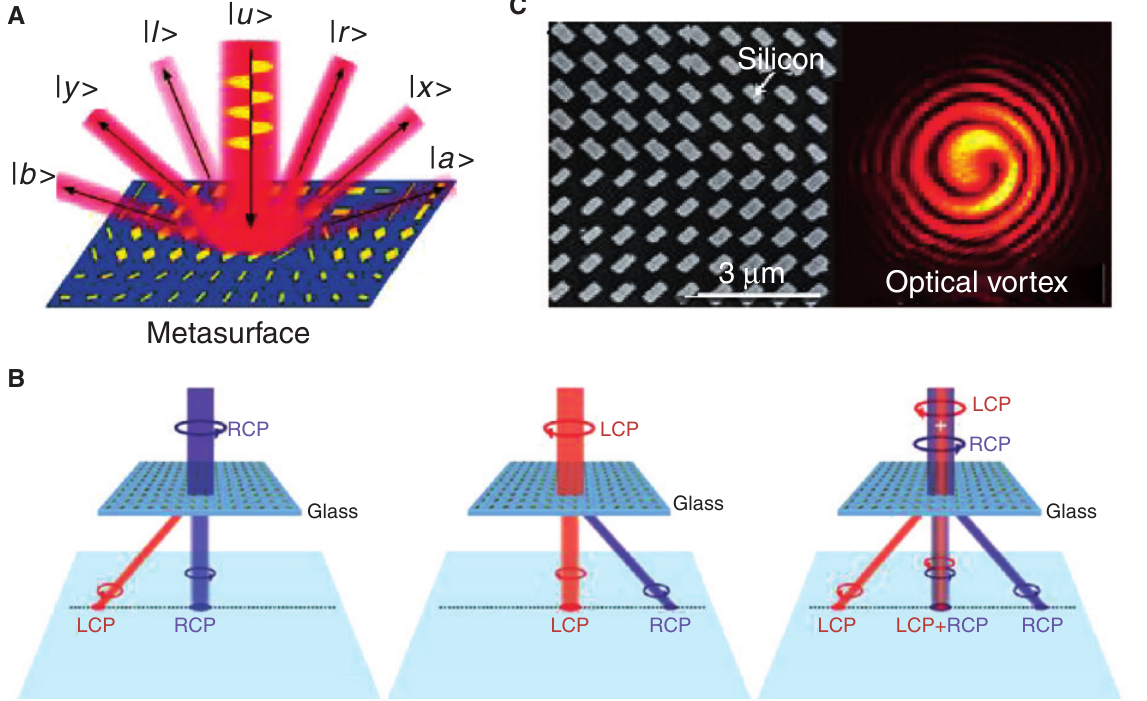
Figure 10: OAM generators and detectors. (A and B) Geometric-phase metasurface in sorting different polarizations. Reprinted from Refs. [113, 114], respectively. (C) Generating optical angular momentum by metasurface. Reprinted from Ref.